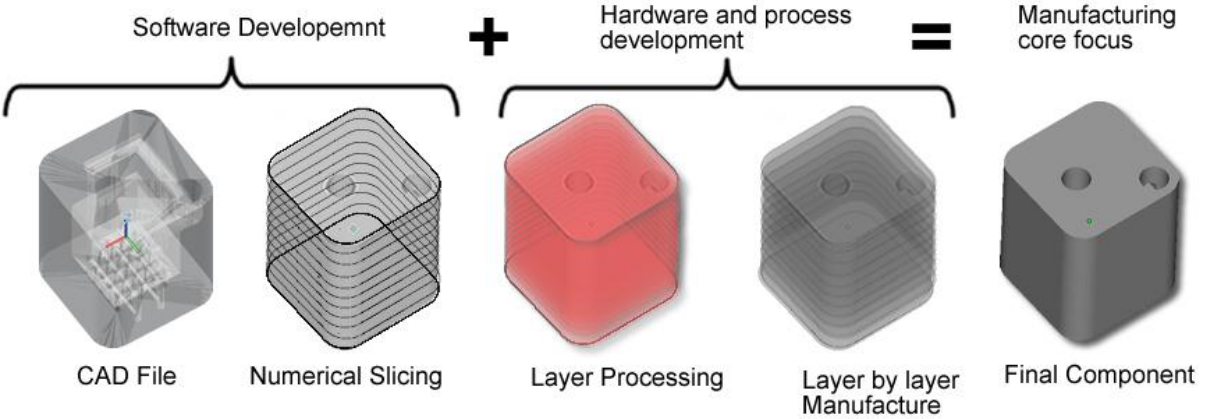
Figure 1. Flow diagram of ALM system from computer-aided design (CAD) file through to component